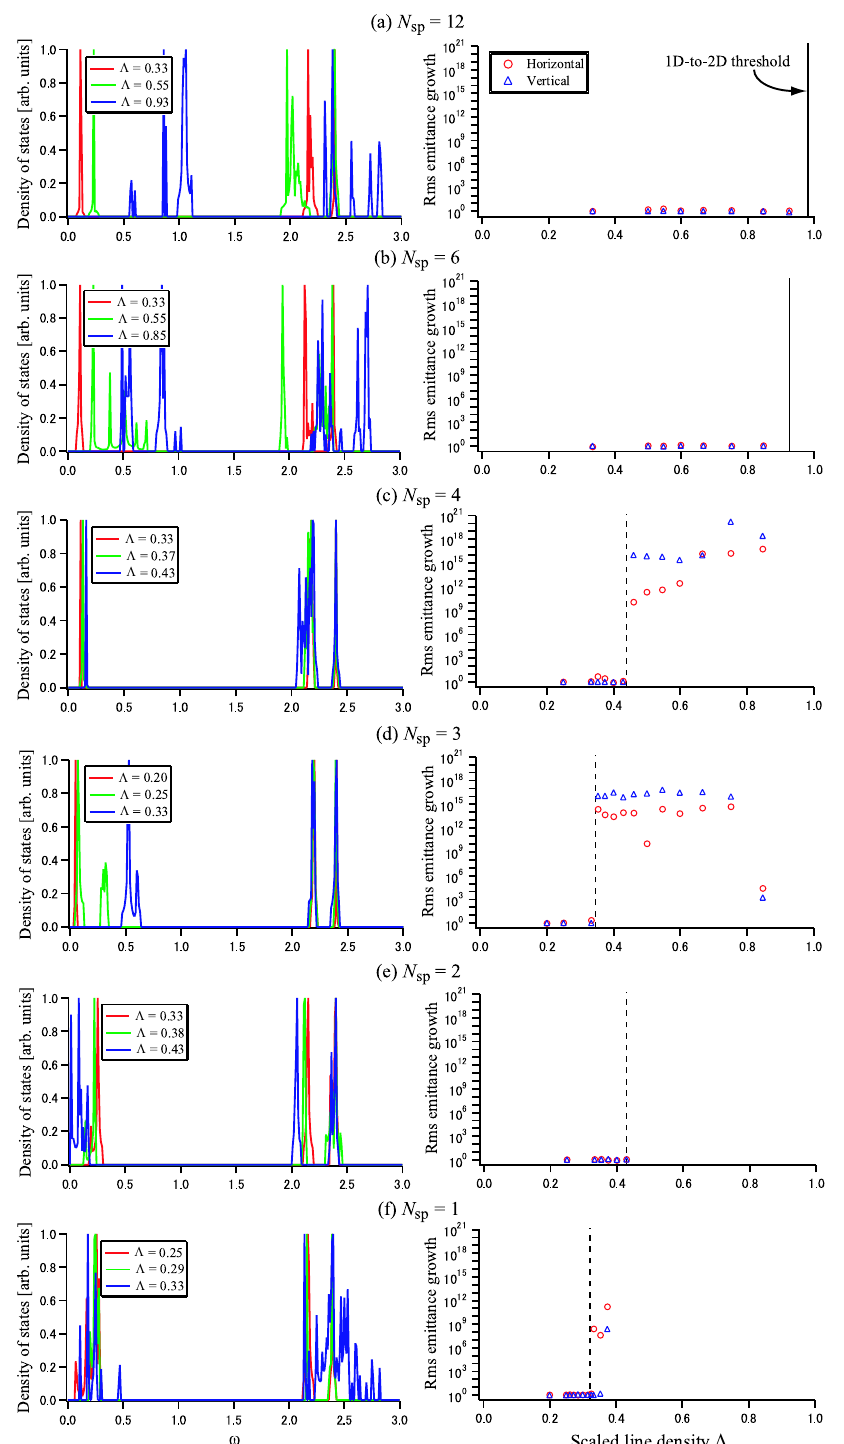
FIG. 6. (Color) Density of states and stability diagrams of 1D crystalline beams evaluated with MD simulations using MD supercells (cid:2) 12 ; 6 ; 4 ; 3 ; 2 ; 1 are used to verify the results in Sec. II A. In all cases, the bare of 24 particles. FODO-based model rings with N sp (cid:5) (cid:2) (cid:3) 2 : 4 ; 2 : 2 (cid:5) . The vertical solid line in the stability diagrams indicates the threshold of 1D-to-2D transition, ; (cid:2) betatron tunes are (cid:3) (cid:2) x y while the broken line is the stability border of the 1D crystals. The parameter (cid:2) represents the scaled line density evaluated in the beam rest-frame. The actual line density in the laboratory frame is given by (cid:7) (cid:2) (cid:2) = (cid:3) (cid:1)(cid:4) (cid:5) . For example, for 24 Mg (cid:4) ions with a kinetic energy of 360 keV ( (cid:1) (cid:2) 1 : 000 016 ) in a storage ring of 1 m bending radius, we obtain (cid:1)(cid:4) (cid:2) 12 : 6 (cid:9) m . The stability of a 1D crystal at specific line density is determined by checking the rms emittance 100 turns after removing the cooling